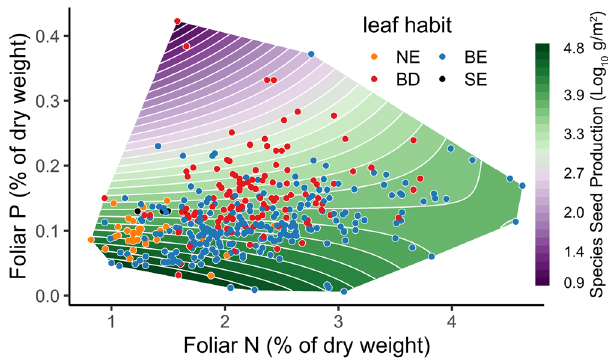
Fig. 3 Effects of foliar nutrients on seed production. Effects of foliar nitrogen (N) and phosphorus (P) on SSP (g seed per m 2 tree basal area) from the model in Supplementary Table 1 plotted for the broadleaf deciduous leaf habit (other leaf types exhibit same patterns). The convex hull for the surface is restricted to the data coverage. Symbols indicate leaf habit, including broadleaf deciduous (BD), broadleaf evergreen (BE), needleleaf evergreen (NE), and scalelike